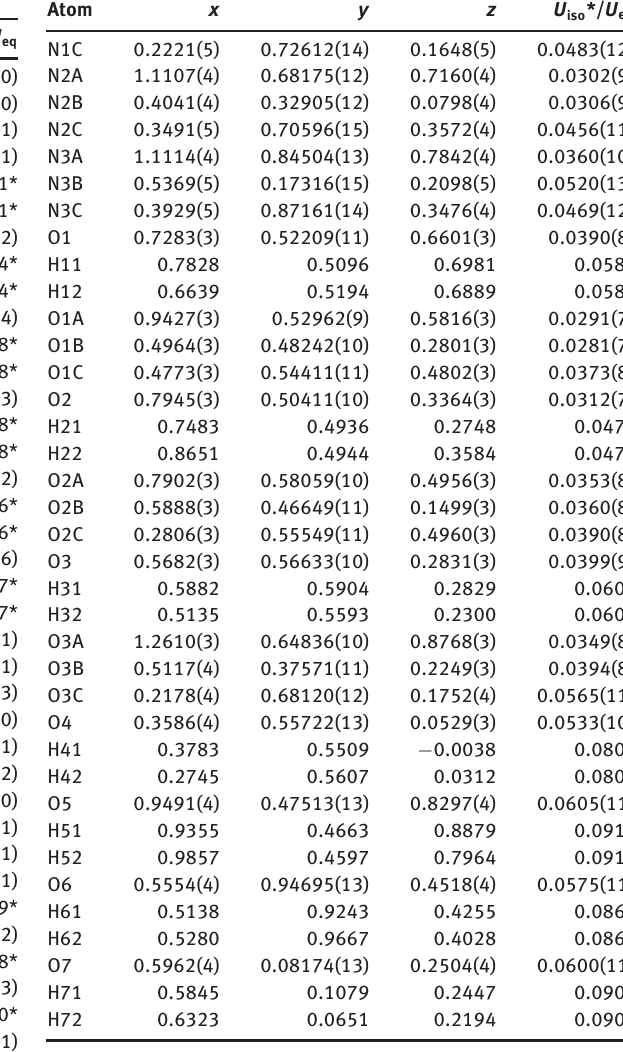
Table 2: Fractional atomic coordinates and isotropic or equivalent isotropic displacement parameters (Å 2